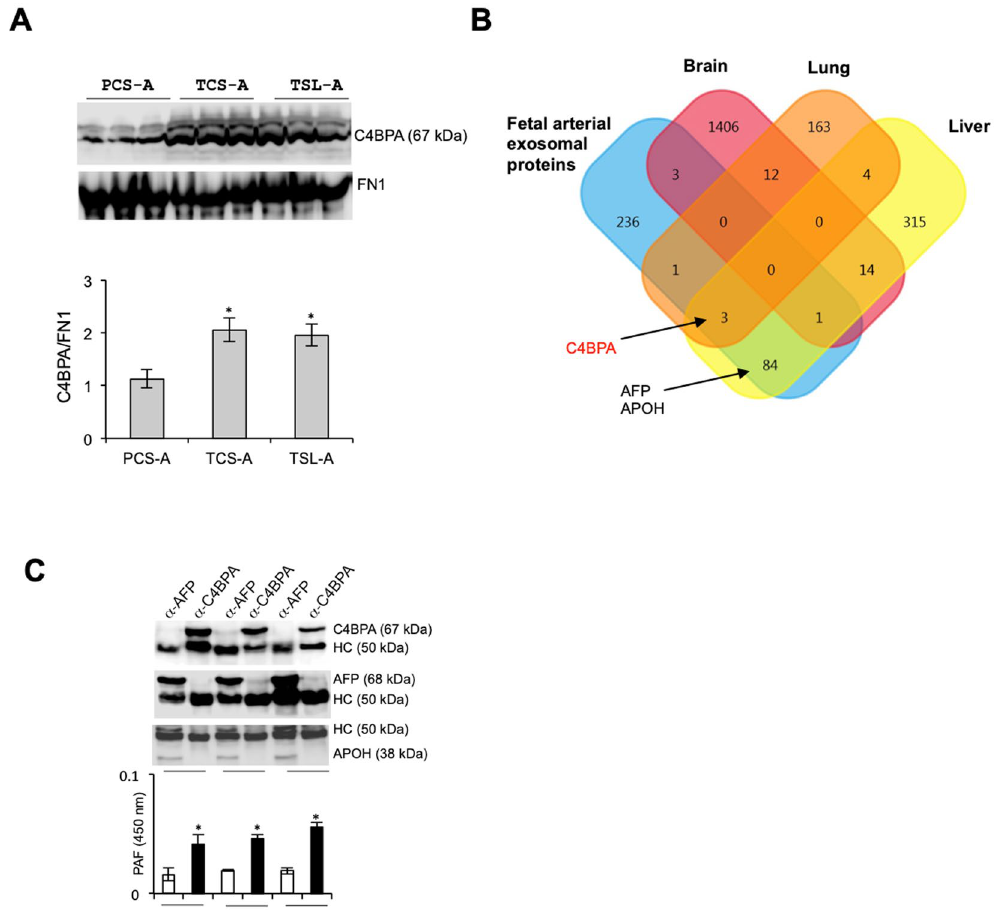
Figure 2. C4BPA is contained in fetal lung exosomes. ( A ) Validation of differential abundance of exosomal C4BPA among groups as indicated by Western blot analysis (top panels). C4BPA abundance was normalized to FN1 and quantified with use of ImageJ program 33 . Student t-test was used compare either results of the TCS-A or TSL-A with those of the PCS-A. * p < 0.01 (N = 3 individual samples). ( B ) Venn diagram showing number of tissue-specific proteins that were obtained from the Human Protein Atlas 15 , indicating that C4BPA, which was identified in fetal exosomes, originates from fetal liver or lung, whereas AFP and APOH are found exclusively in liver. ( C ) Anti-C4BPA or -AFP antibody was used in immunoprecipitation (IP) assay of fetal exosomes prepared from the samples of 3 individual TCS-A and IPs were analyzed by means of Western blot for the listed proteins or by ELISA for identifying PAF. The bars represent average of A450 values and standard deviation from triplicates by the same IPs. Student t-test was used to compare values of A450 between α -AFP and α -C4BPA within the same sample. * p <